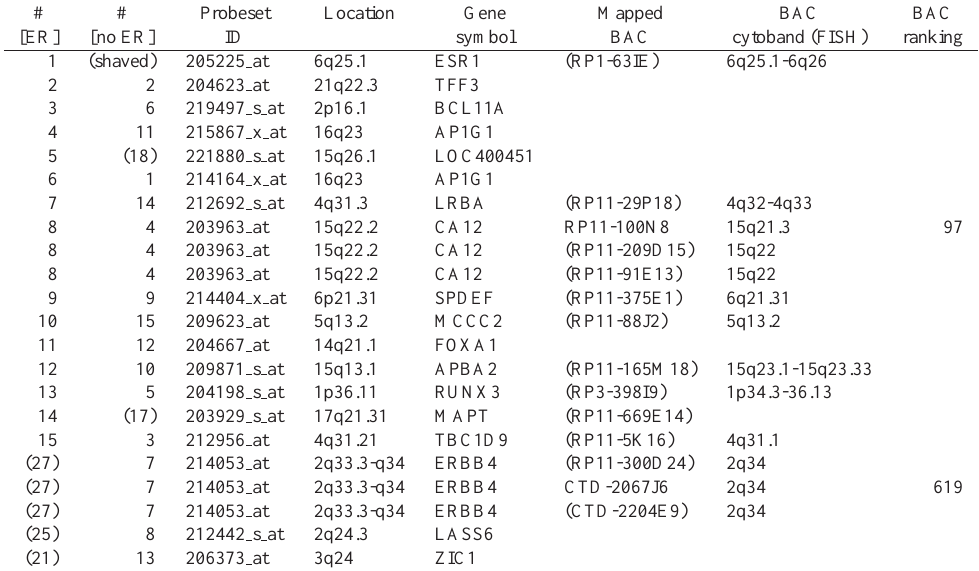
T able 3: Mapping of the top-15 ranked probesets on the available BAC. Probeset ranking position for gene expression classification is listed for ESR1 probeset included (col. # [ER] ) or excluded # [noER] ). The BAC clones in parentheses are not present (missing or discarded by imputation).